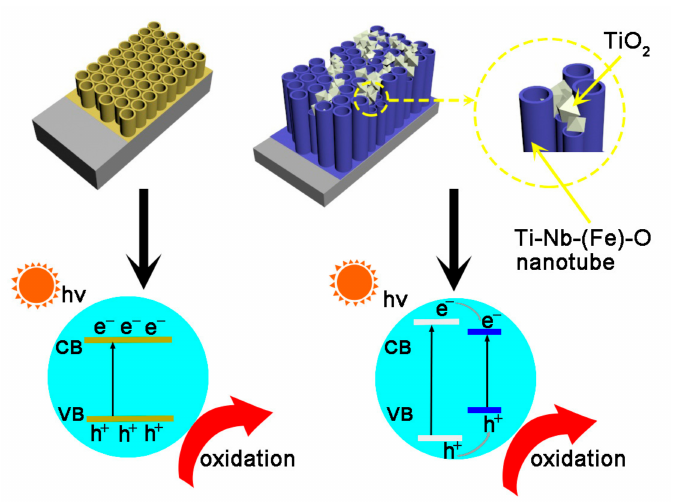
Figure 12. Schematic illustration of the photocatalytic process on TiO 2 nanotubes and Ti-Nb-(x)Fe-O nanotubes in organic pollutant